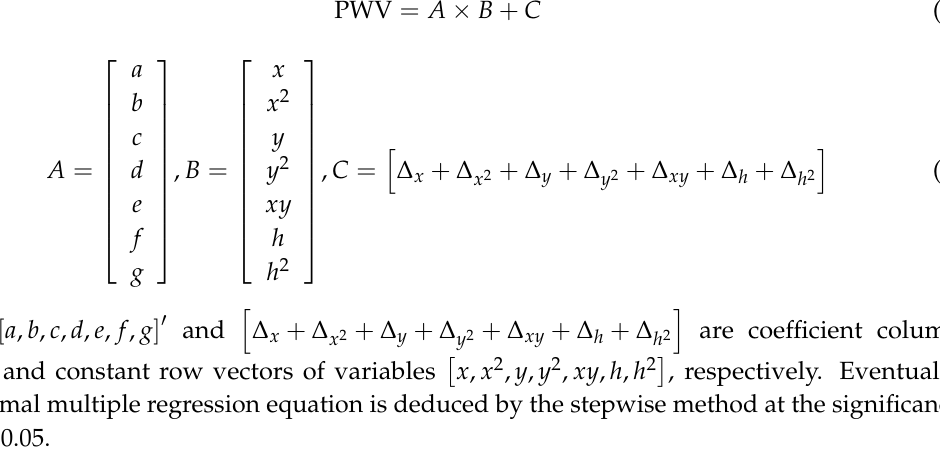
constant row vectors of variables 222 ,,,,,, xxyyxy hh   , respectively. Eventually, the optimal multiple regression equation is deduced by the stepwise method at the significance level of 0.05.